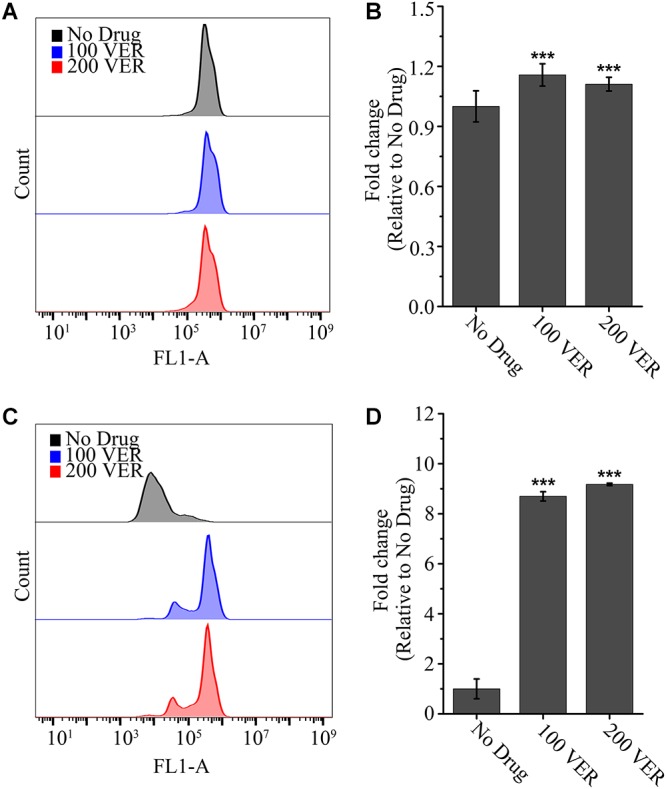
Pretreatment with verapamil increases the efflux of Rh 6G. The uptake (A) and efflux (C) of Rh 6G were assayed with or without pretreatment of 100 or 200 μg/ml VER in an A. fumigatus strain by flow cytometry analysis. FL1-A represents the relative fluorescence intensity value. Normalized quantification of the fluorescence intensity is shown in bar graph (B,D) relative to that of the No Drug group. Values represent the mean ± SD of three replicates. ∗∗∗p < 0.001.